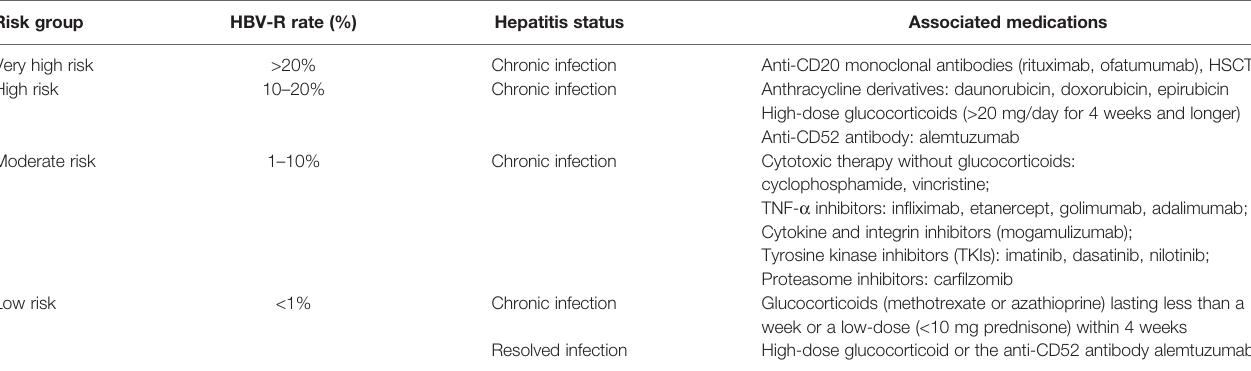
TABLE 2 | HBV-R risk groups based on patient infection status and associated immunosuppressive